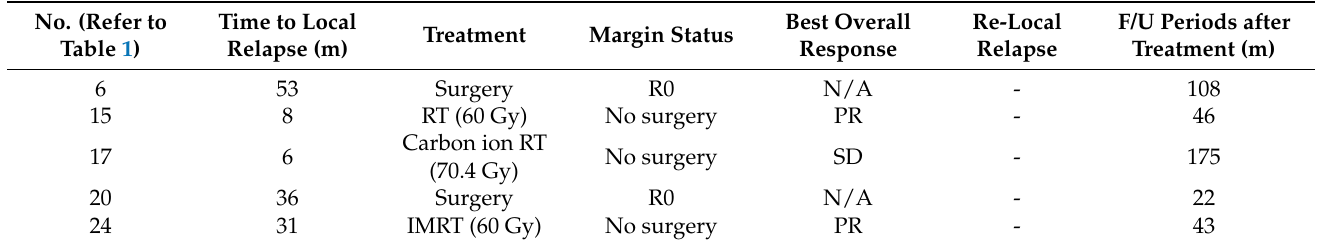
Table 4. Treatment for local tumor